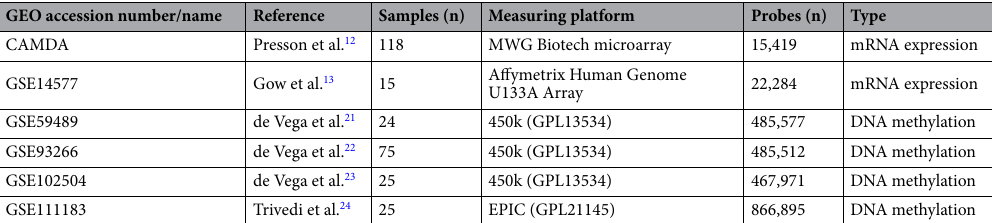
Table 2. Characteristics of the mRNA expression and DNA methylation